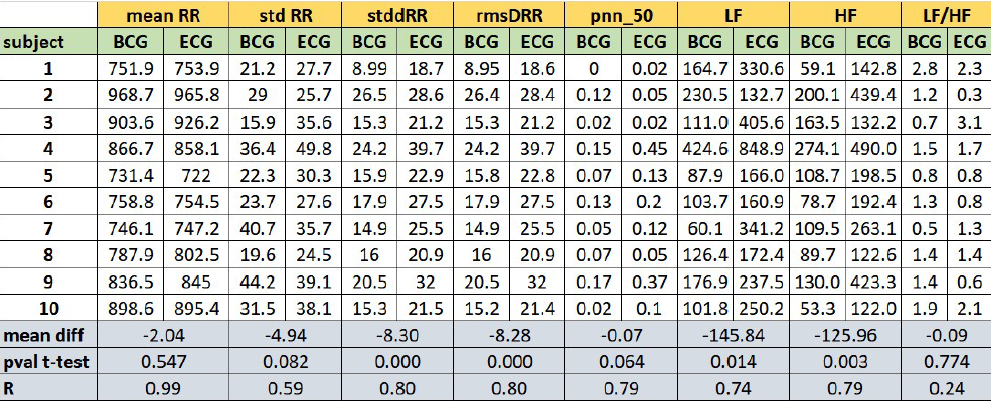
Figure 6. Comparative table of HR and HRV parameters between the estimation from ECG and BCG: mean RR interval (meanRR, in msec), standard deviation of RR intervals (stdRR, in msec), standard deviation of differences between adjacent RR intervals (stdDRR, in msec), root mean square of differences of successive RR intervals (rmsDRR, in msec), number of successive difference of intervals which differ by more of 50 msec divided by the total number of RR intervals (pnn50, adimensional number), absolute power of the low-frequency band (0.04–0.15 Hz-LF, in dB), absolute power of the high-frequency band (0.15–0.4 Hz-HF, in dB) and the ratio of absolute powers between low-frequency and high-frequency bands (LF/HF, adimensional number). The mean differences (mDs), the p -values ( p -values) of mean differences and Pearson’s correlation coefficients (R) between the BCG and ECG estimations for all parameters are also